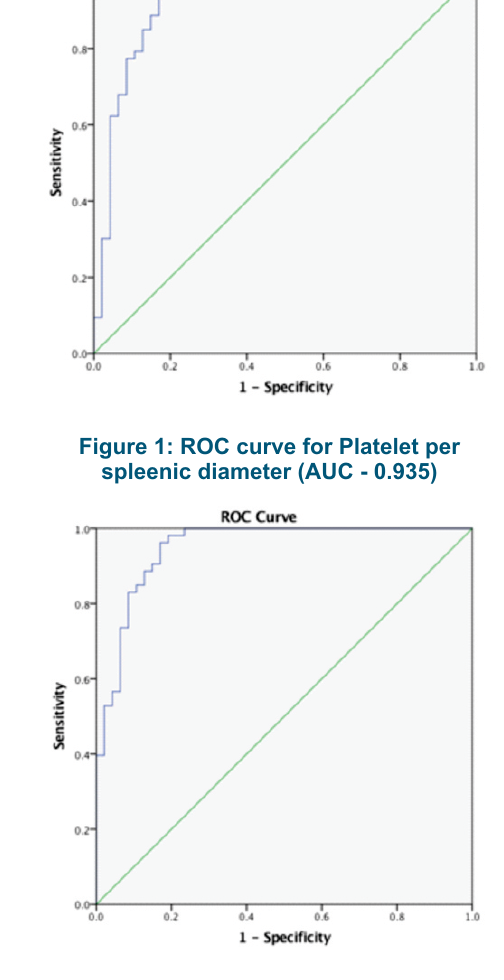
Figure 2: ROC curve for Platelet per splenic diameter per PT (AUC-